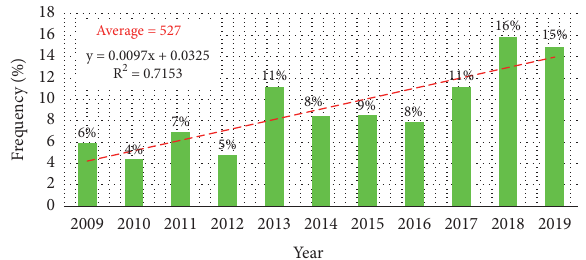
Figure 13: Annual frequencies of TSRA occurrences at VYYY (shaded bar) with their trend (red-dotted line) during 2009–2019.